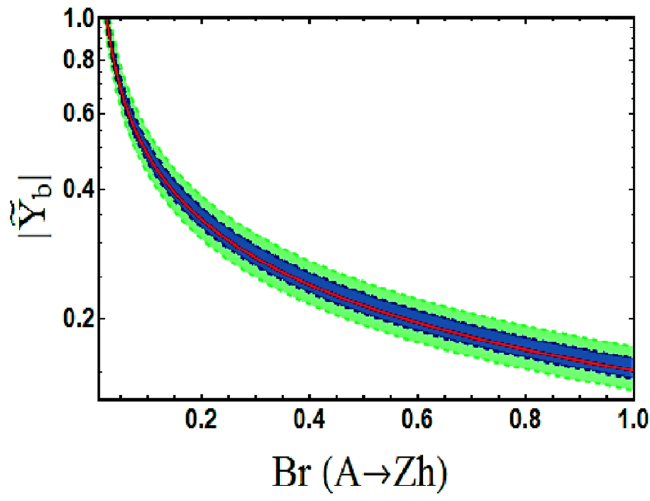
Figure 13 . The parameter space in bottom Yukawa ( ~ Y b ) and Br ( A ! Zh ) plane consistent with 440 GeV excess. The blue and green regions correspond to the 1 (cid:27) and 2 (cid:27) bands on the observed